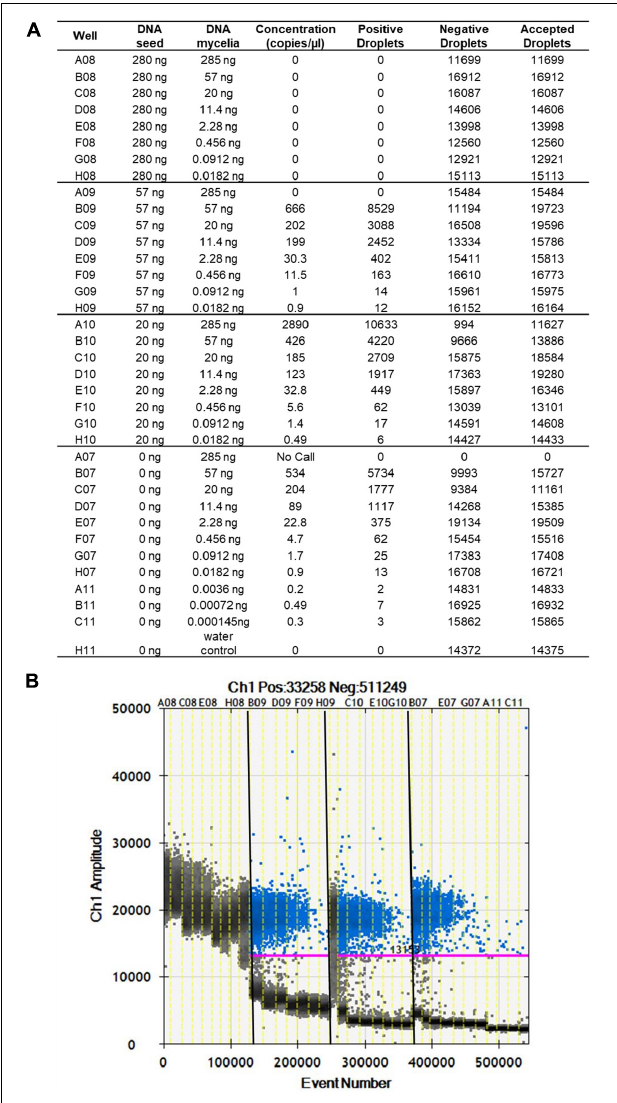
FIGURE 2 | Analysis of spike samples obtained without and with mixing DNA from healthy seeds at different concentrations (as indicated) with DNA mycelia of S. cucurbitacearum at different concentrations (as indicated). (A) Absolute quantification. (B) Fluorescence amplitude. Pink line, threshold above which positive droplets (blue) contain at least one copy of target DNA, and below which negative droplets (gray) contain no copies of target DNA. Different sample sets in (A) are divided by vertical dotted yellow lines in (B) . Wells A08 to H08 showed saturation signals.